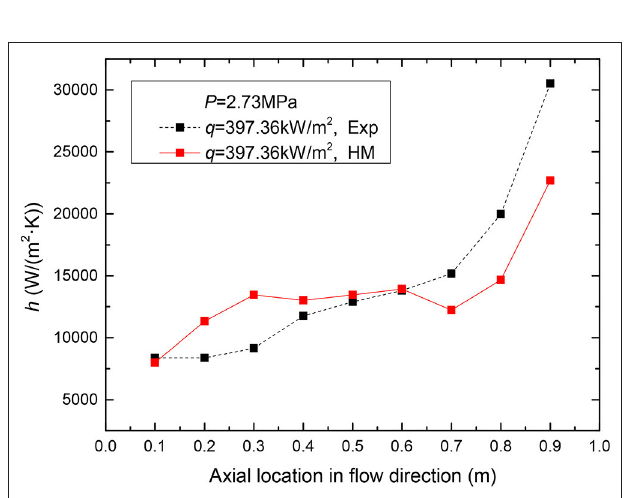
FIGURE 11 | The comparisons between experimental and numerical heat transfer coefficients for q = 397.36 kW/m 2 and G = 500 kg/(m 2 · s).